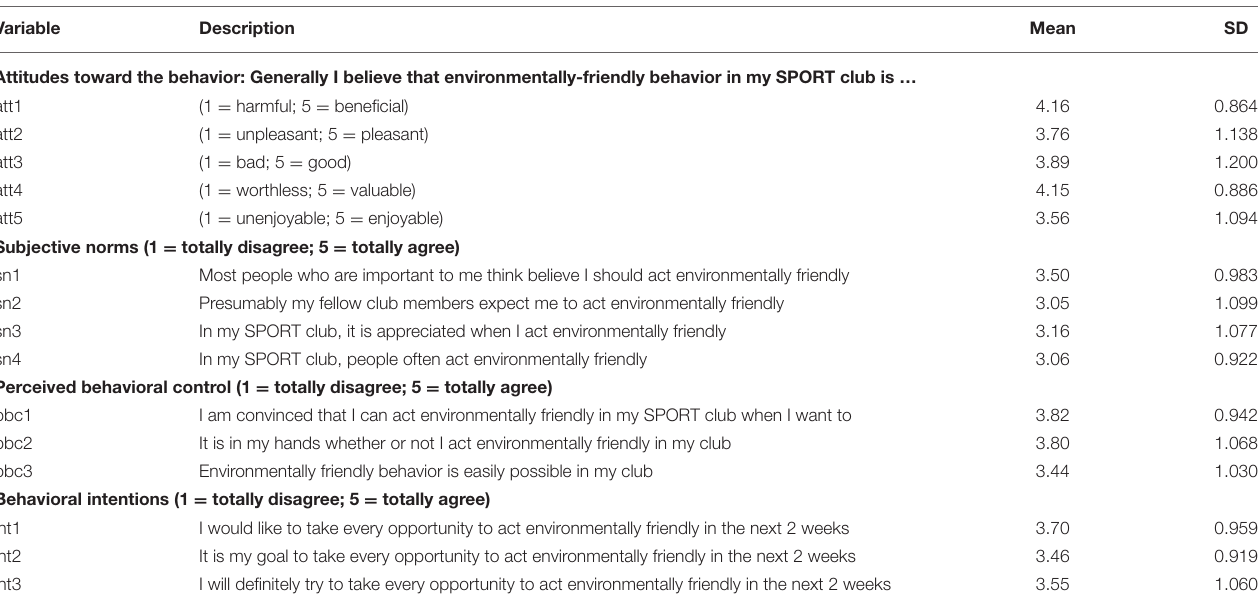
TABLE 2 | Overview of